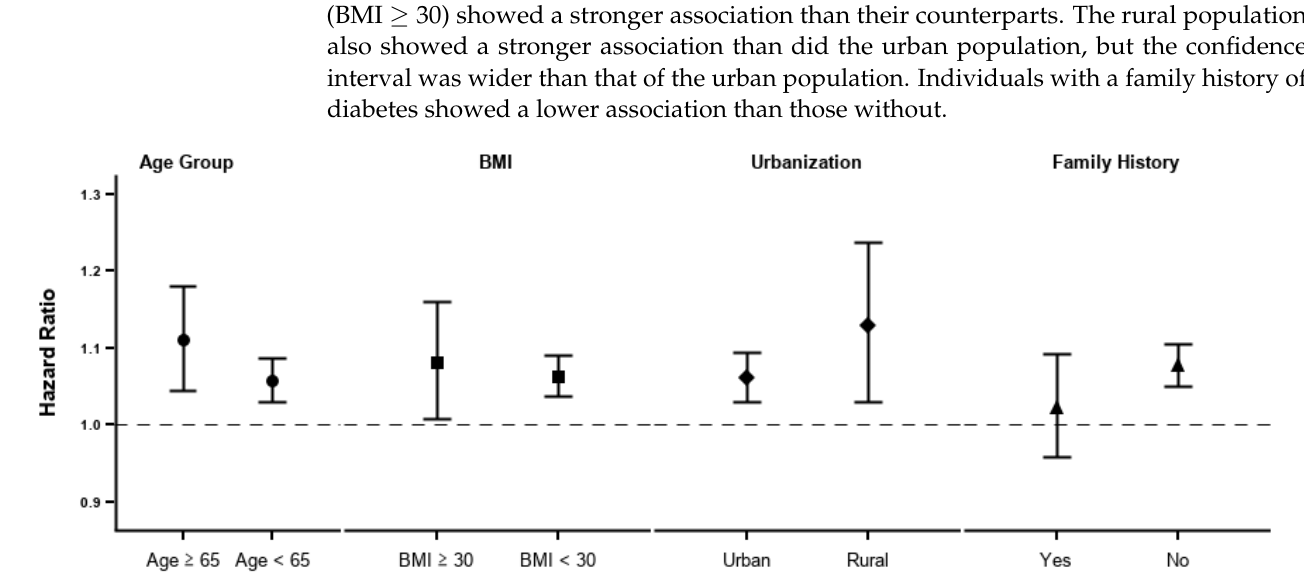
Figure 2. Hazard ratios a for incident type 2 diabetic mellitus by diagnostic test and time window. Note: measurement of PM 2.5 started in 2000, but the beginning of our study period was 2005; as we used a moving average over six years, we therefore restricted our outcome dataset to time points in 2006 and later.